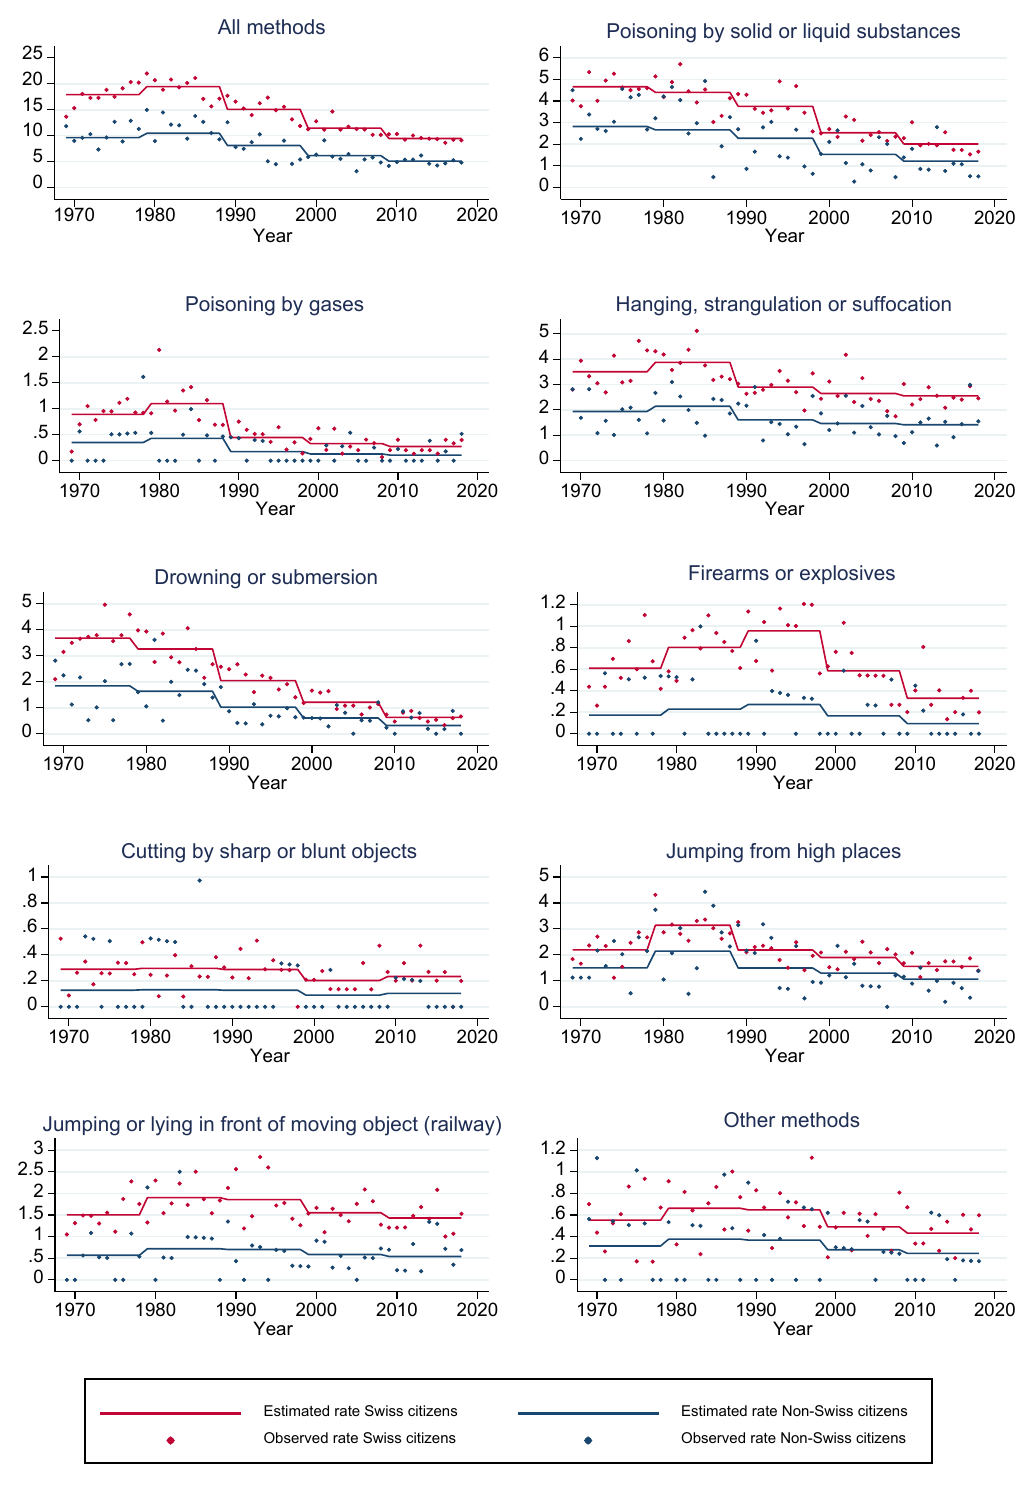
Figure S6. Rates of suicide methods per 100'000 population (person-years) in 30-64 years old